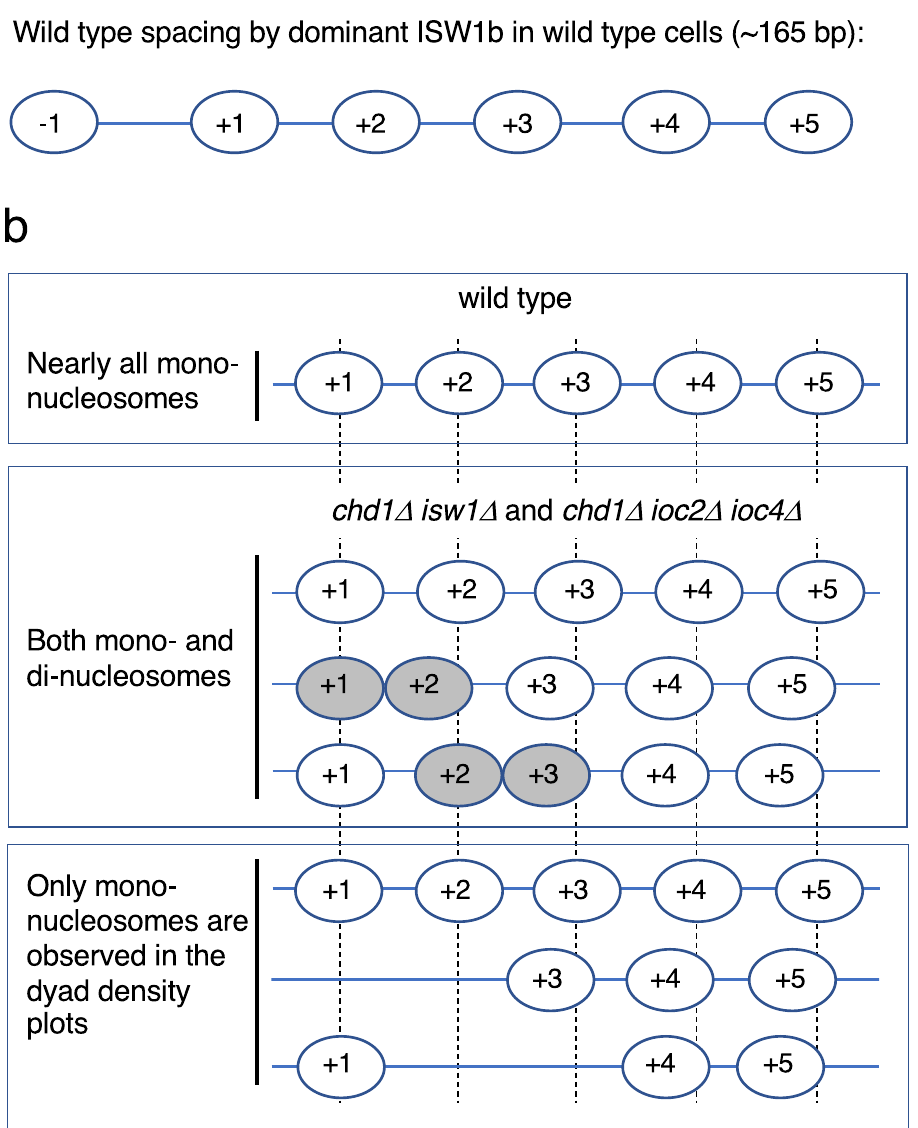
Figure 6. Dominant role of ISW1b in chromatin organisation. ( a ) Global average nucleosome spacing is primarily determined by ISW1b (wild type cells), since loss of ISW1a has little effect. Short spacing is attributed to Chd1, because the chd1∆ isw1∆ double mutant has highly disrupted chromatin. ( b ) Dinucleosomes disrupt phasing and reduce spacing. Model to show the effects of dinucleosomes on chromatin organisation. Top panel: Average nucleosome positions on a gene in wild type cells with regular spacing. Middle: Close- packed dinucleosomes (grey ovals) are high in the absence of both ISW1b and Chd1. These dinucleosomes preferentially involve the + 2 nucleosome i.e., they are mostly + 1/+ 2 or + 2/+ 3 dinucleosomes. Nucleosomes farther down the gene (+ 3 etc.) may be regularly spaced relative to the dinucleosome, but because a linker is missing in the dinucleosome, downstream nucleosomes are out of phase with other nucleosomal arrays, resulting in poor phasing due to interference patterns from the different arrays. Bottom: Dinucleosomes are absent from the mononucleosome dyad density plots, resulting in depressed, flattened peaks. These effects are strongest in cells lacking both ISW1b and Chd1. Dinucleosomes that cannot be resolved by ISW1b can account for shorter spacing in chd1∆